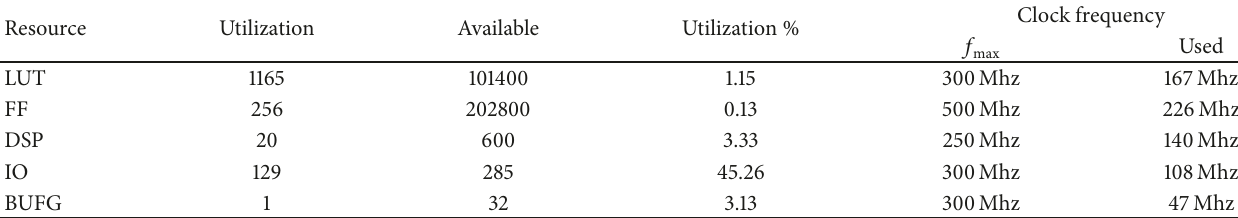
Table 5: Resource utilization of FONCS-1